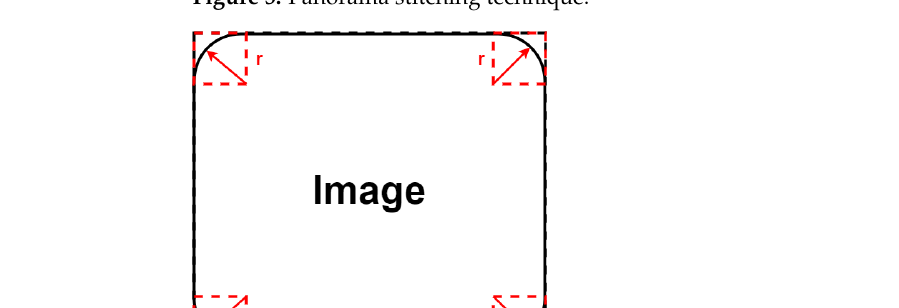
Figure 5. Panorama stitching technique.